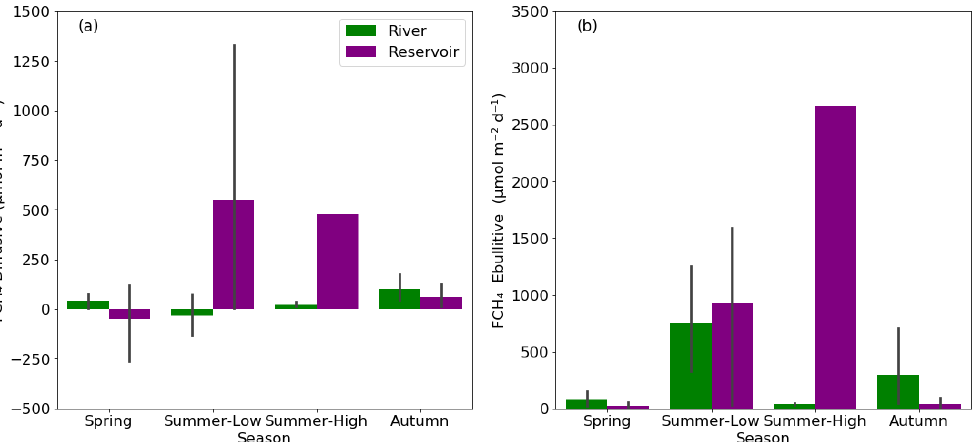
Figure 5. The bar charts showing the diffusive FCH 4 ( a ) and ebullitive FCH 4 ( b ) pattern in different seasons between rivers and reservoirs. The grey error bars represent the range of 95% confidence interval. Note: The error bars for the diffusive and ebullitive FCH 4 results were absent in the summer-high flow period because only one reservoir was sampled for CH 4.